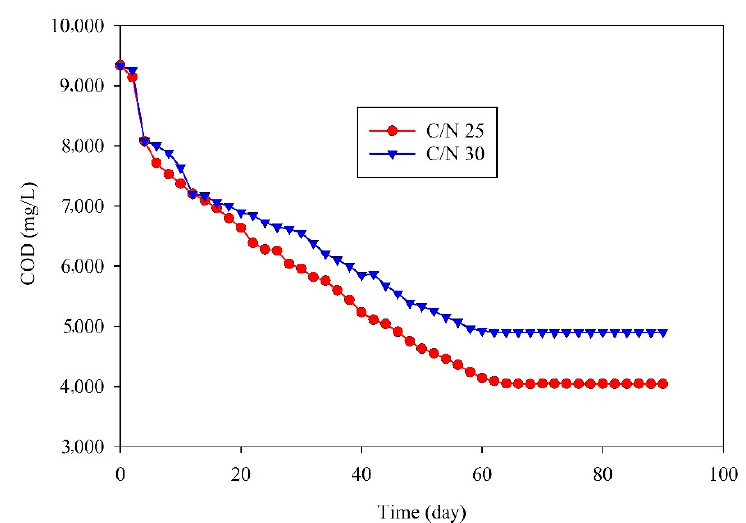
Figure 6. Effect of different C/N ratios on the chemical oxygen demand (COD) reduction of 20% total solids (TS) biogas with delignification.